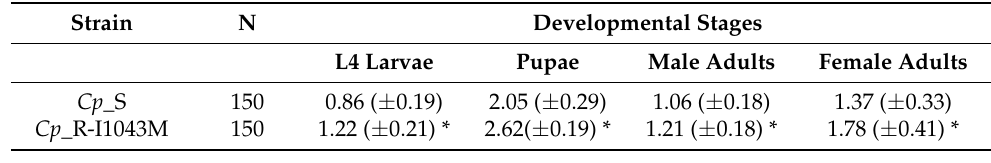
Table 3. Cuticle thickness in susceptible and resistant Cx. pipiens mosquitoes. The cuticle thickness is reported for all the life stages analysed and the values are expressed in μm. N = number of mos- quitoes analysed for each strain. The values are reported as the mean ± standard errors (* p < 0.001, Mann– Whitney test).